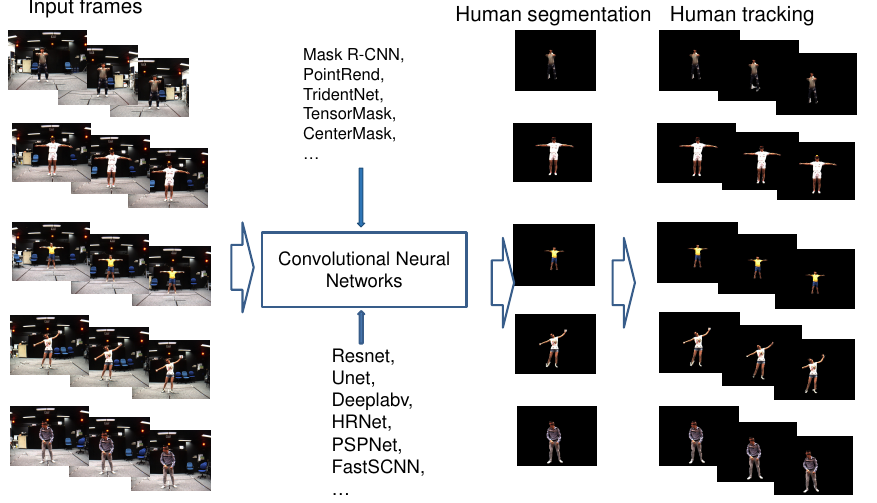
Figure 1. Illustrating of the process of segmenting and tracking humans in image sequences and